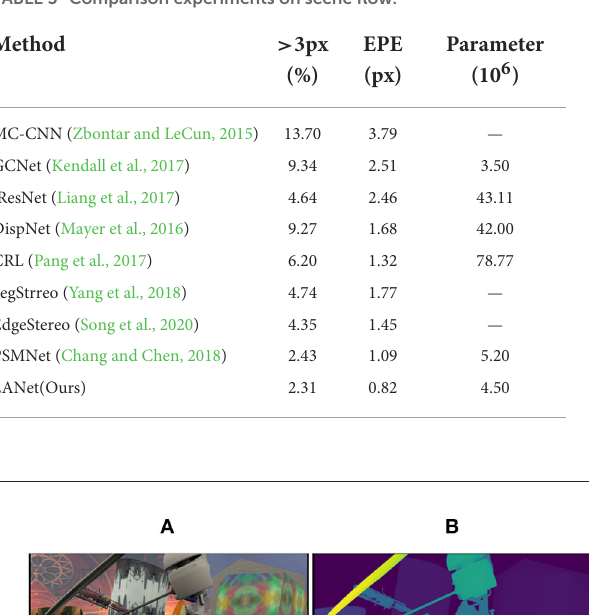
TABLE 5 Comparison experiments on scene flow.